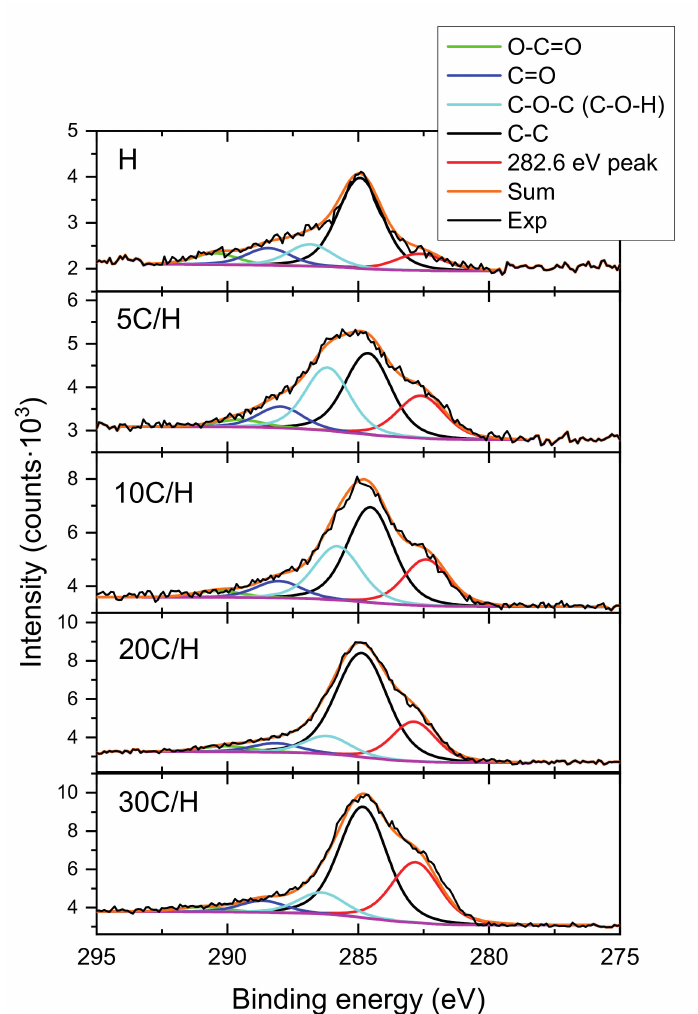
Figure 2. The results of the C1s peak decomposition into components corresponding to di ff erent carbon bonds, obtained for purified halloysite sample (H), and 5 C / H, 10 C / H, 20 C / H, and 30 C / H halloysite-carbon nanocomposites. The spectra were not normalized to adventitious carbon C-C peak